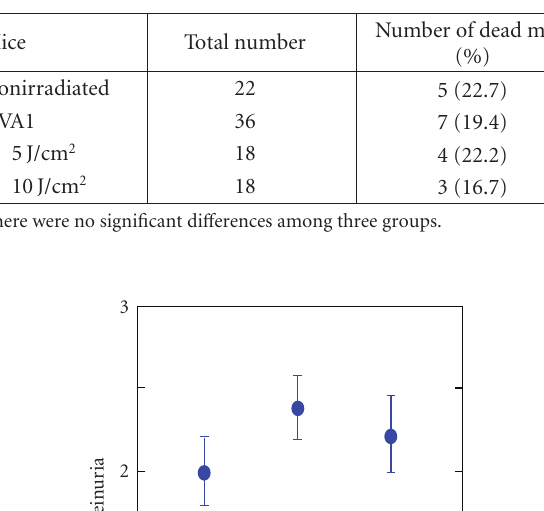
Table 2: Mortality of MRL/lpr mice during experimental period. Regarding the mortality of MRL/lpr mice during the experimental period, UVA1 irradiation tended to decrease the mortality of mice, but not significantly.